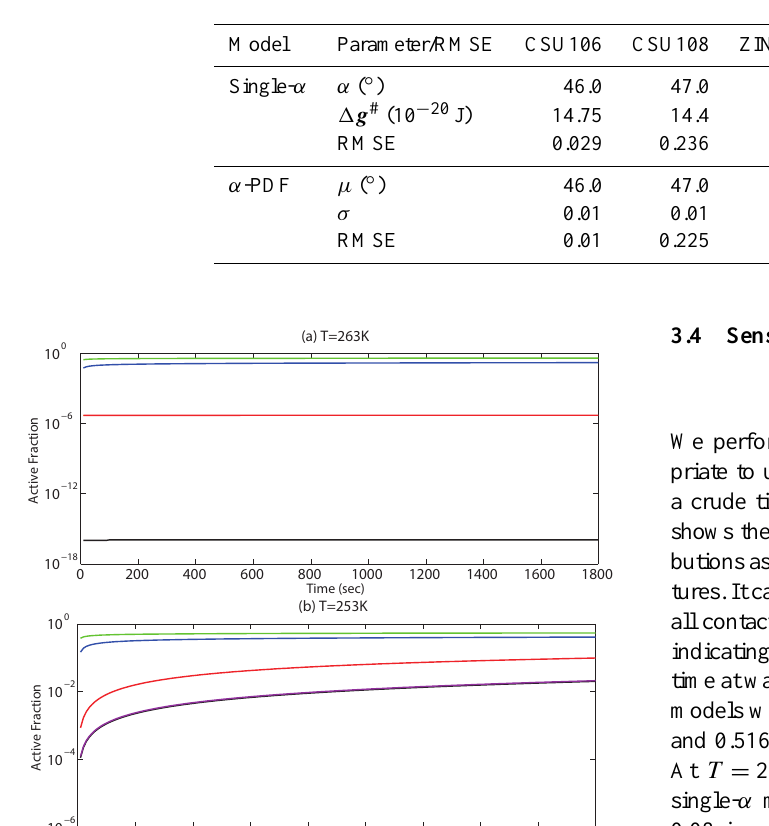
Table 2. Fit parameters obtained for the two models for immersion freezing by dust. The root mean square errors (RMSEs) between the fit curves and the data are given. In the table, µ is the mean contact angle; σ is the standard deviation.